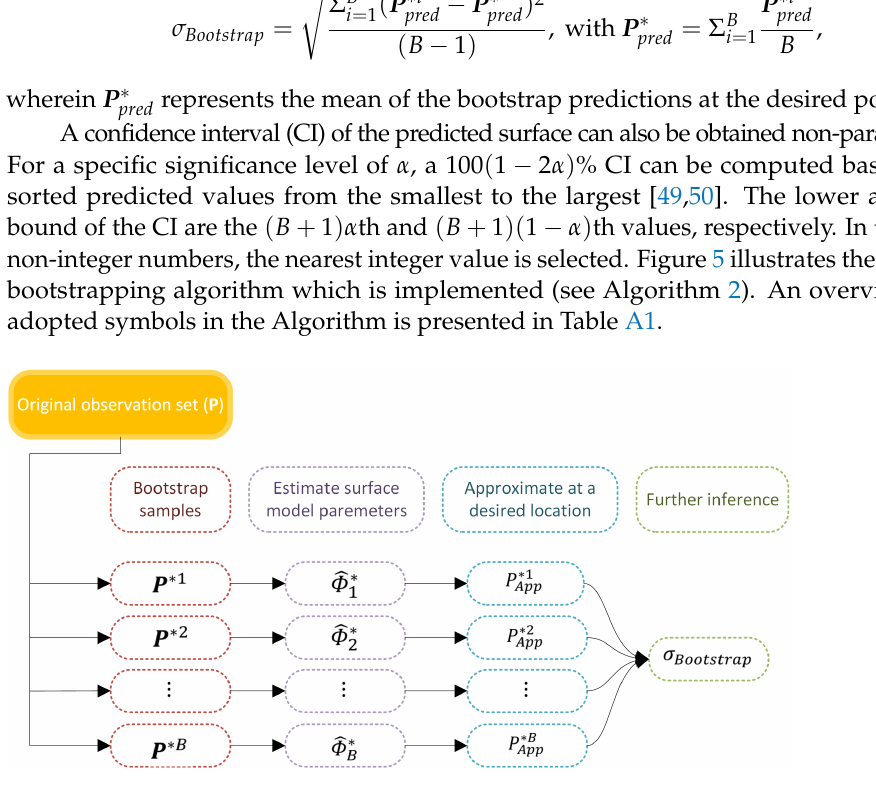
Figure 5. Overview of the implemented bootstrapping